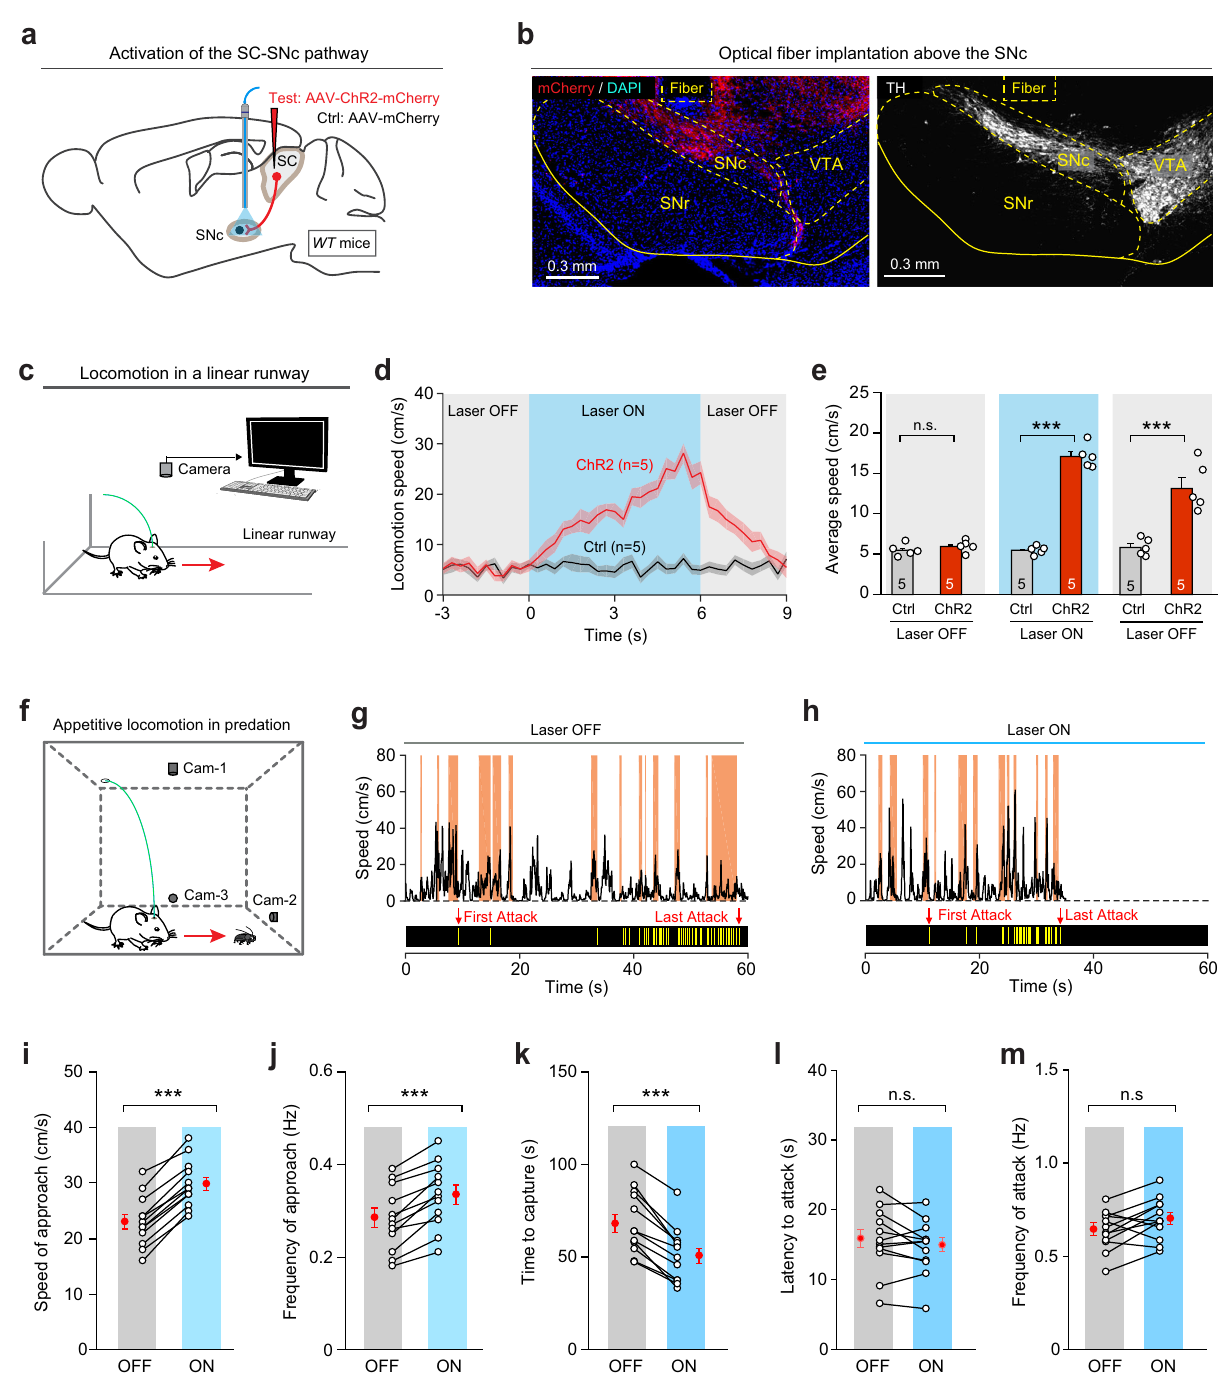
Fig. 7 Activation of the SC – SNc pathway promoted appetitive locomotion. a Schematic diagram showing injection of AAV-ChR2-mCherry into the SC of WT mice, followed by optical fi ber implantation above the SNc. b An example coronal section of ventral midbrain with an optical- fi ber track above the ChR2-mCherry + axon terminals in the SNc (left), the boundary of which was delineated by the immuno fl uorescence of TH (right). This experiment was repeated independently in 12 mice with similar results. c Schematic diagram showing the experimental con fi guration to monitor mouse locomotor behavior in the linear runway. d Time courses of locomotion speed of control (Ctrl) and test mice (ChR2) in the linear runway before, during and after light stimulation of the SC – SNc pathway (10 Hz, 20 ms, 6 s, 10 mW). e Quantitative analyses of average locomotion speed of control (Ctrl) and test mice (ChR2) before, during, and after photostimulation of the SC – SNc pathway. f Schematic diagram showing the experimental con fi guration to monitor predatory hunting in the arena. g , h Behavioral ethograms showing the time courses of locomotion speed (top) and jaw attacks (bottom) during predatory hunting of an example mouse without ( g ) and with ( h ) photostimulation of the SC – SNc pathway (10 Hz, 20 ms, 10 mW). The shaded areas (orange) indicated the approach episodes in predatory hunting. For the analyses of azimuth angle and PPD, see Supplementary Fig. 10j, k. i – m Speed of approach ( i ), frequency of approach ( j ), time to capture ( k ), latency to attack ( l ), and frequency of attack ( m ) in predatory hunting of mice without (OFF) and with (ON) photostimulation of the SC – SNc pathway. Number of mice was indicated in the graphs ( d , e , i – m ). Data in d , e , i – m are means ± SEM (error bars). Statistical analyses in e , i – m were performed by one-sided Student ’ s t -tests ( n.s. P > 0.1; *** P < 0.001). Scale bars are indicated in the